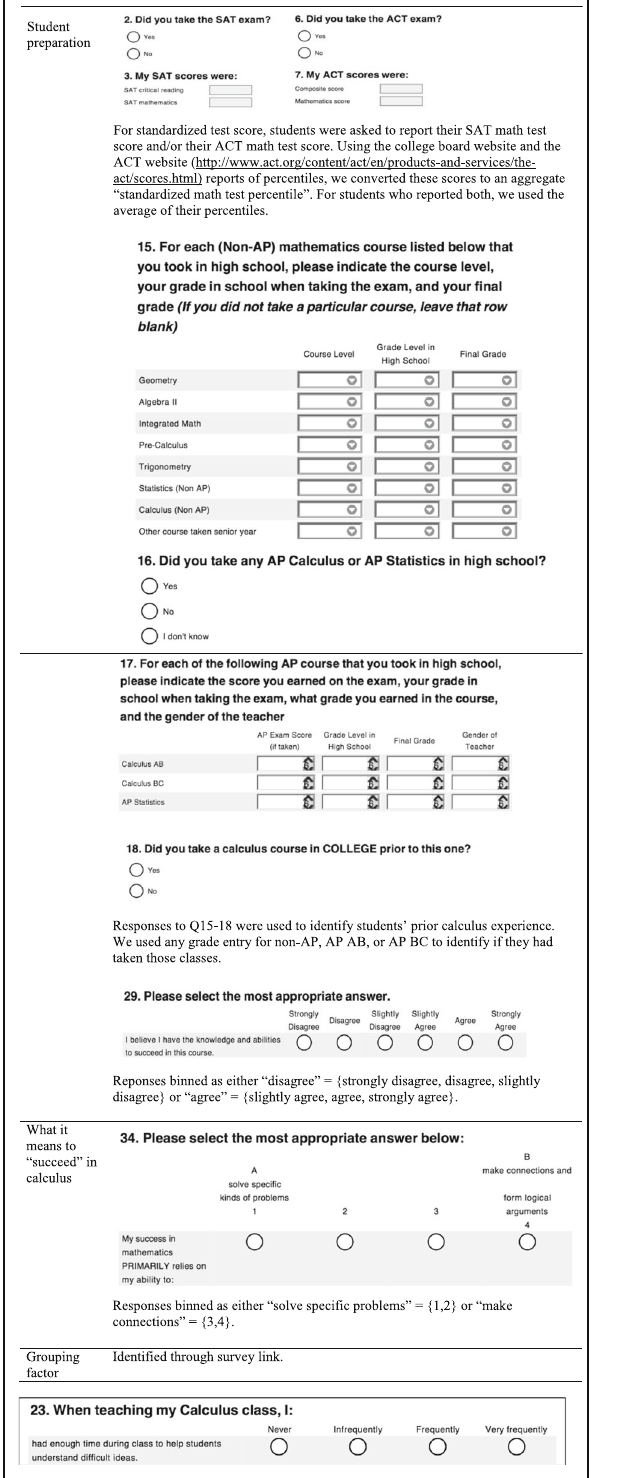
Fig. 4 Instructor output variable. Responses were binned as “ disagree ” ={strongly disagree, disagree, slightly disagree} and “ agree ” ={slightly agree, agree, strongly